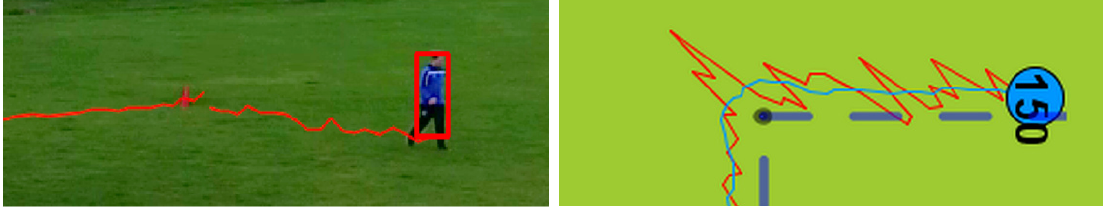
Figure 4. Inaccuracies in trajectories due to erroneous bounding box detections. ( Left ) The calculated bounding box does not match the object exactly. ( Right ) The resulting raw trajectory (red line) is afflicted with significant inaccuracies, which are reduced after having applied a filtering technique (blue line).